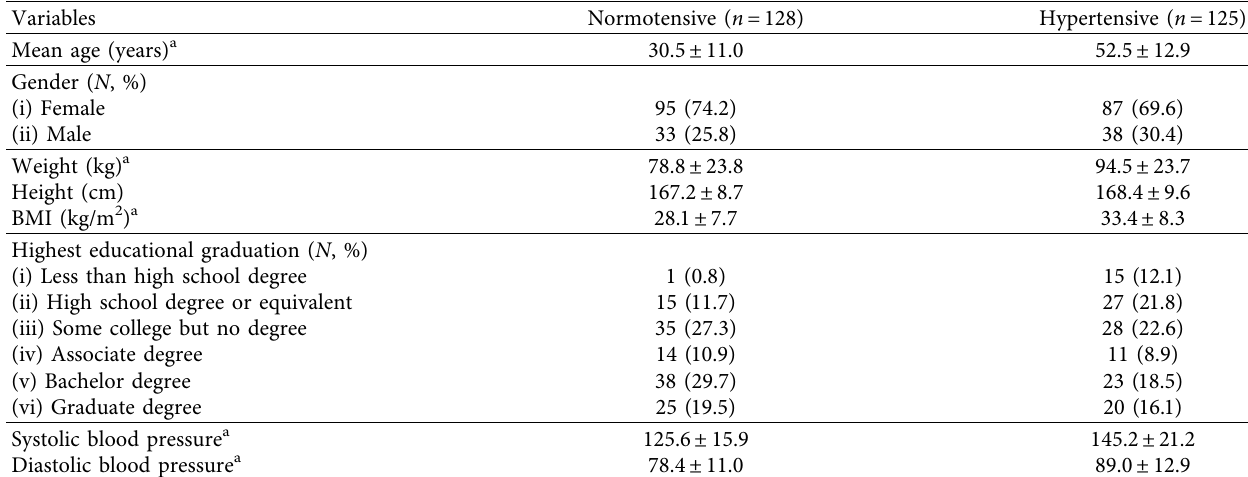
Table 2: General characteristics of 253 adults with and without hypertension.